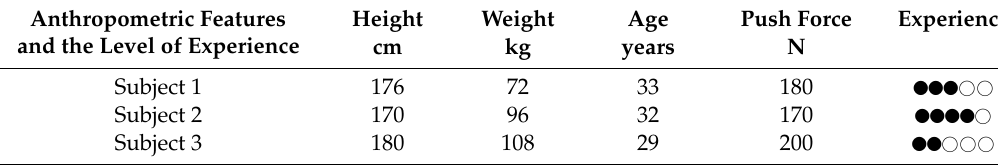
Table 1. Comparison of anthropometric features and the level of experience in wheelchair operation of the test subjects, where push force is a circumferential force applied to the pushrims generated by the upper